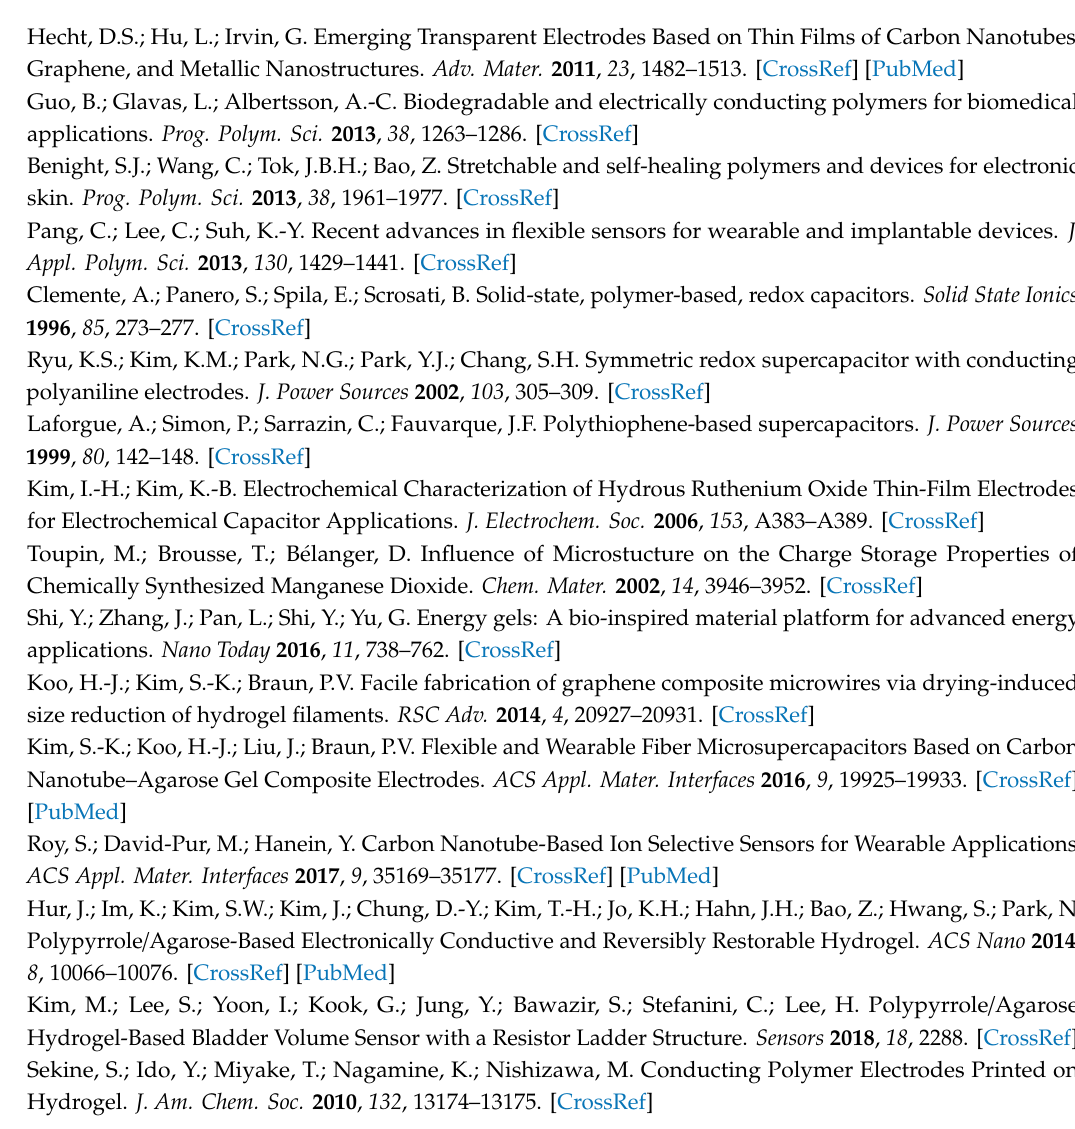
Figure S1: Nitrogen adsorption / desorption isotherms of spherical activated carbon, Figure S2: Optical microscope images of agar / SAC composite gel with circle and line patterns using the PDMS master